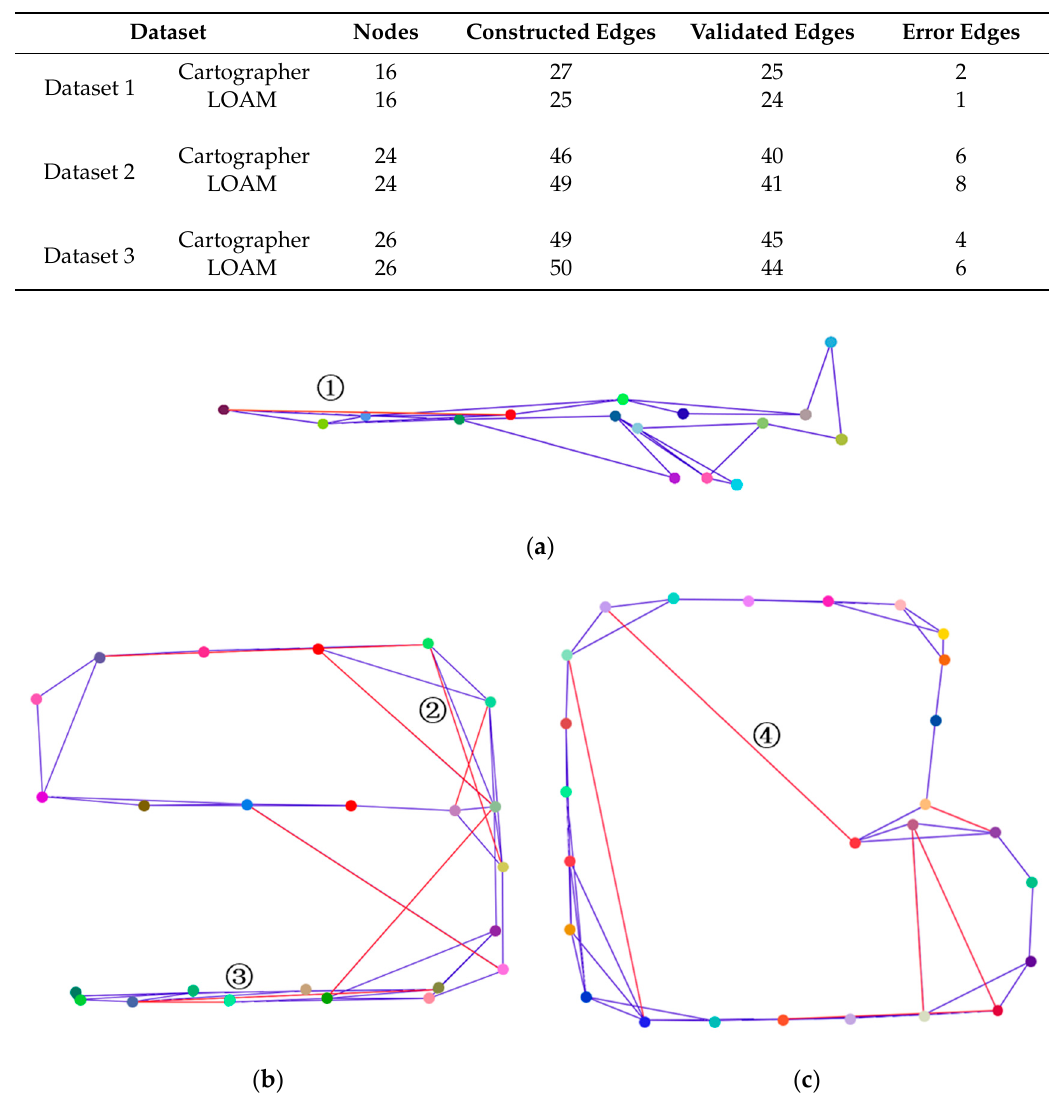
Figure 16. Pose graph visualization result. ( a ) Pose graph of LOAM result in dataset 1; ( b ) pose graph of LOAM result in dataset 2; ( c ) pose graph of LOAM result in dataset 3.